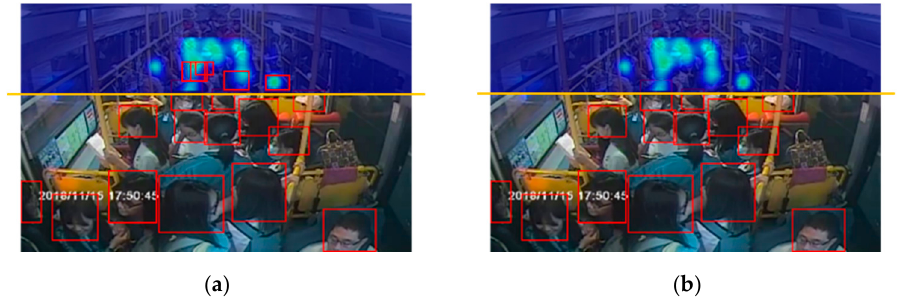
Figure 11. Repeat detection area: ( a ) without correction and ( b ) with correction.